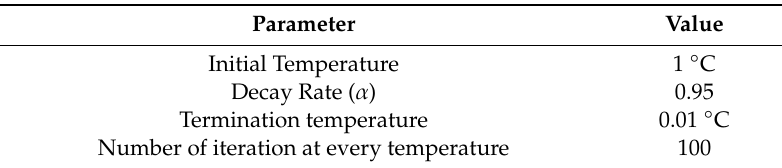
Table 5. Parameters used in SA